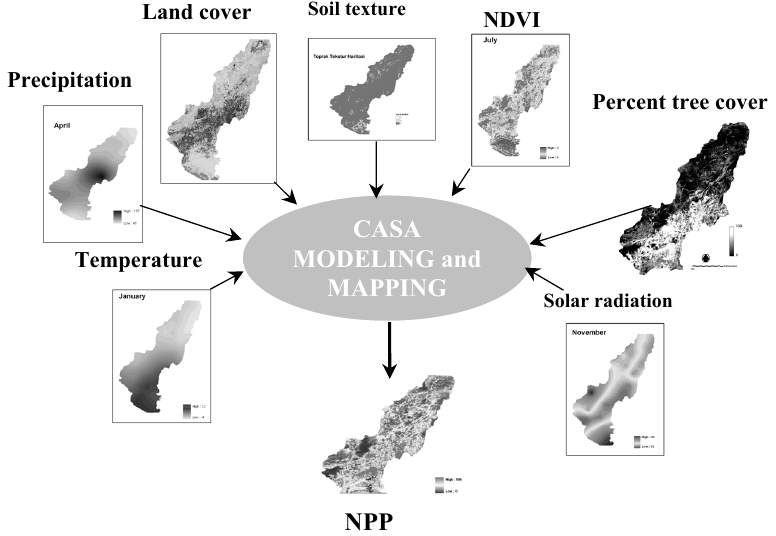
Figure 3. A flow diagram of modeling